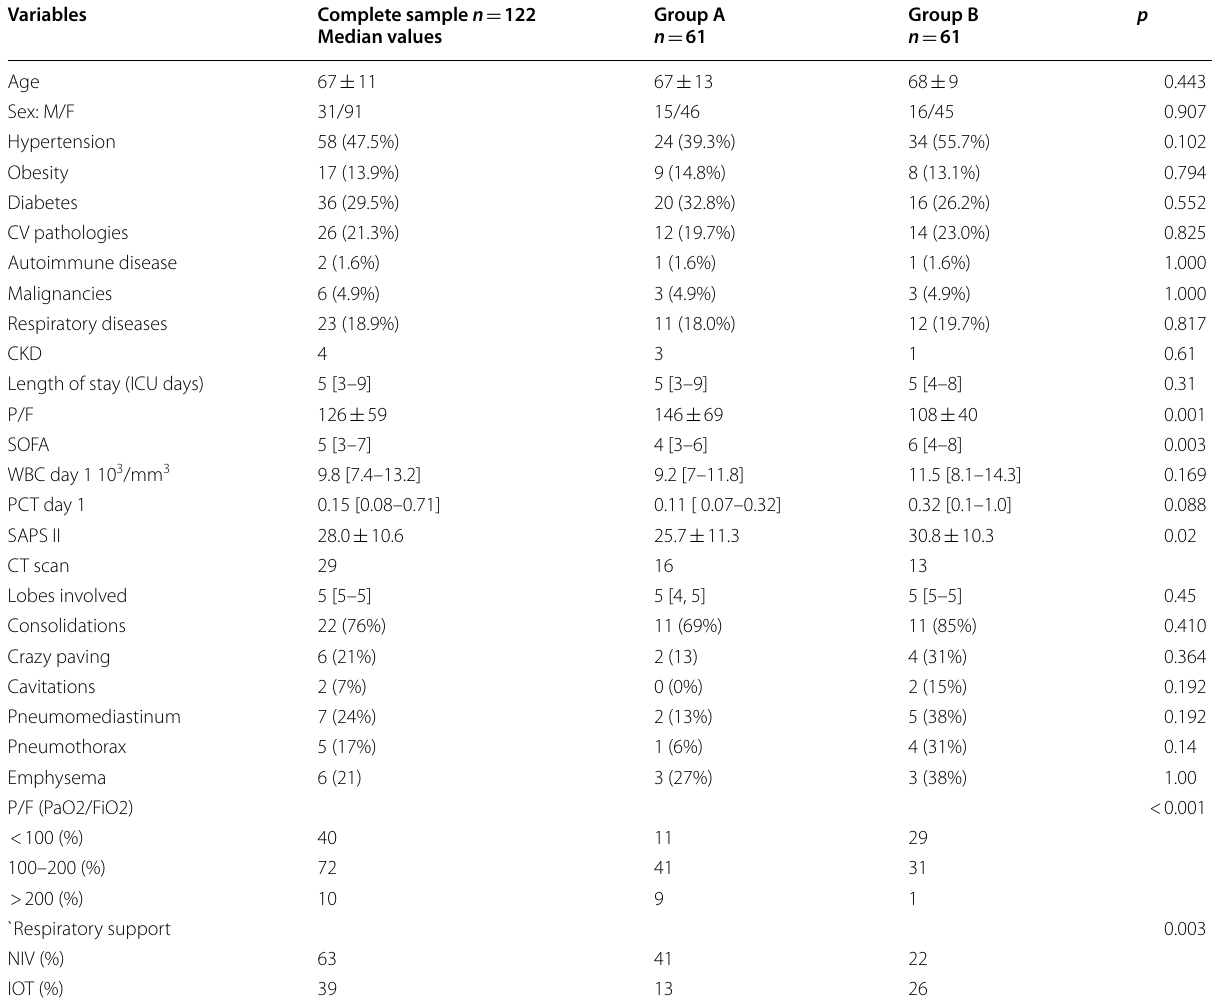
Table 1 Baseline characteristics of source population. Data are presented as mean percentages are reported for categorical